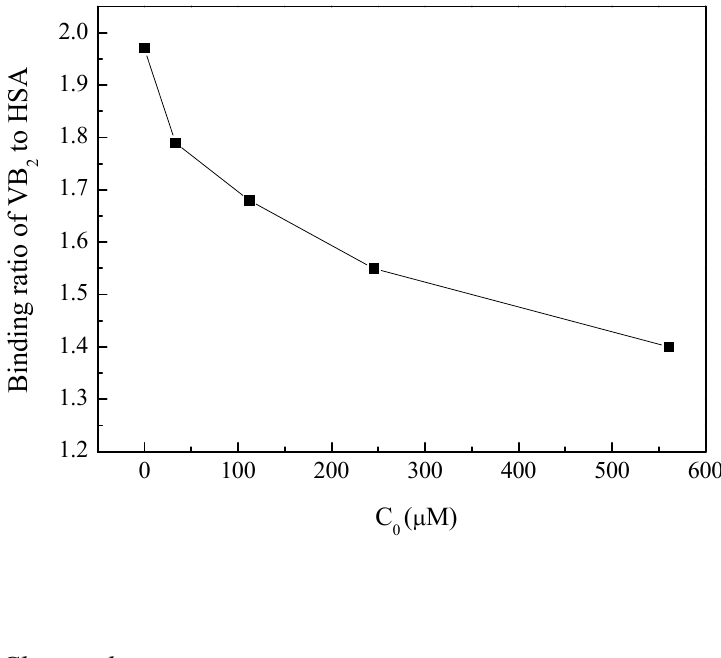
Figure 6. Effects of BZF on the physiological function of HSA to transport VB